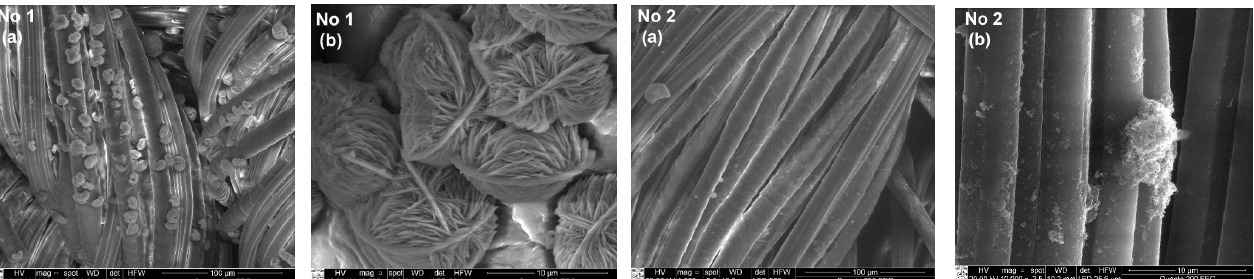
Figure 5. SEM images of non-woven material sample N4 (PES/viscose, 60/40) treated with solutions Materials 2022 , 15 , 7623 Figure 5 No. 1 and No. 2. Magnification: ( a ) 1000 × ; ( b ) 10,000 × .